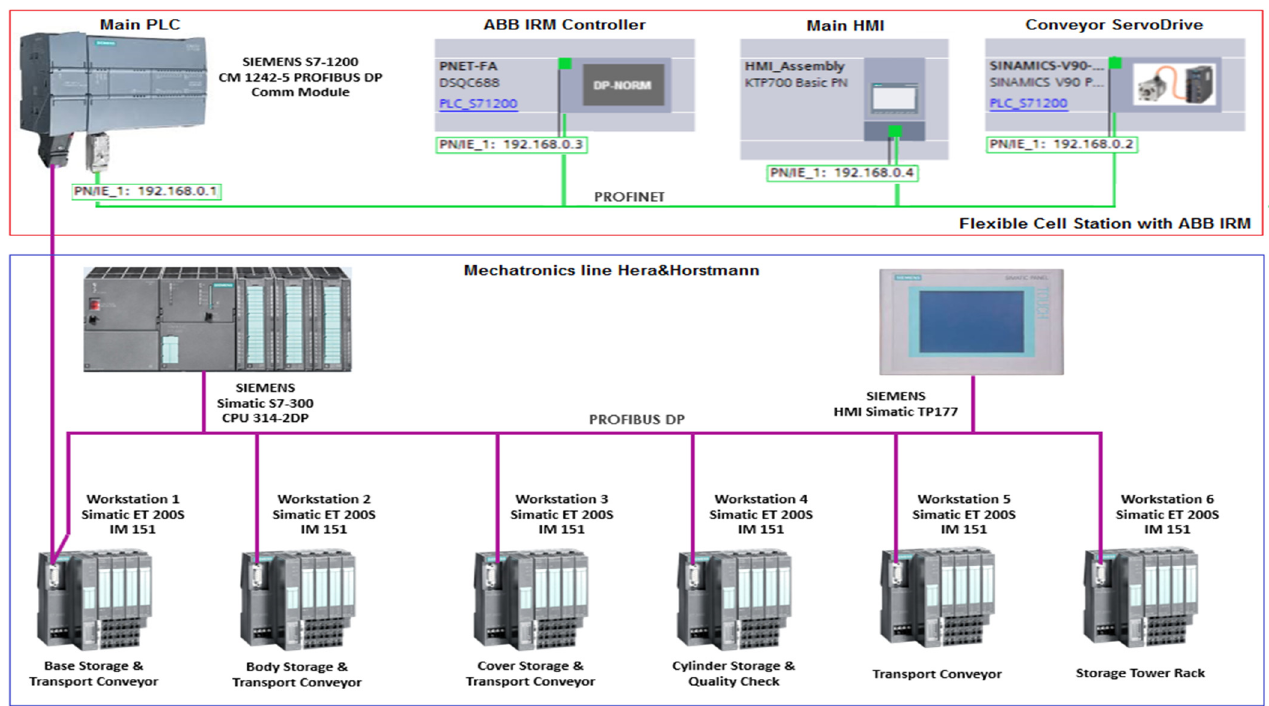
Figure 2. A/D/RML PLC Network hardware structure.